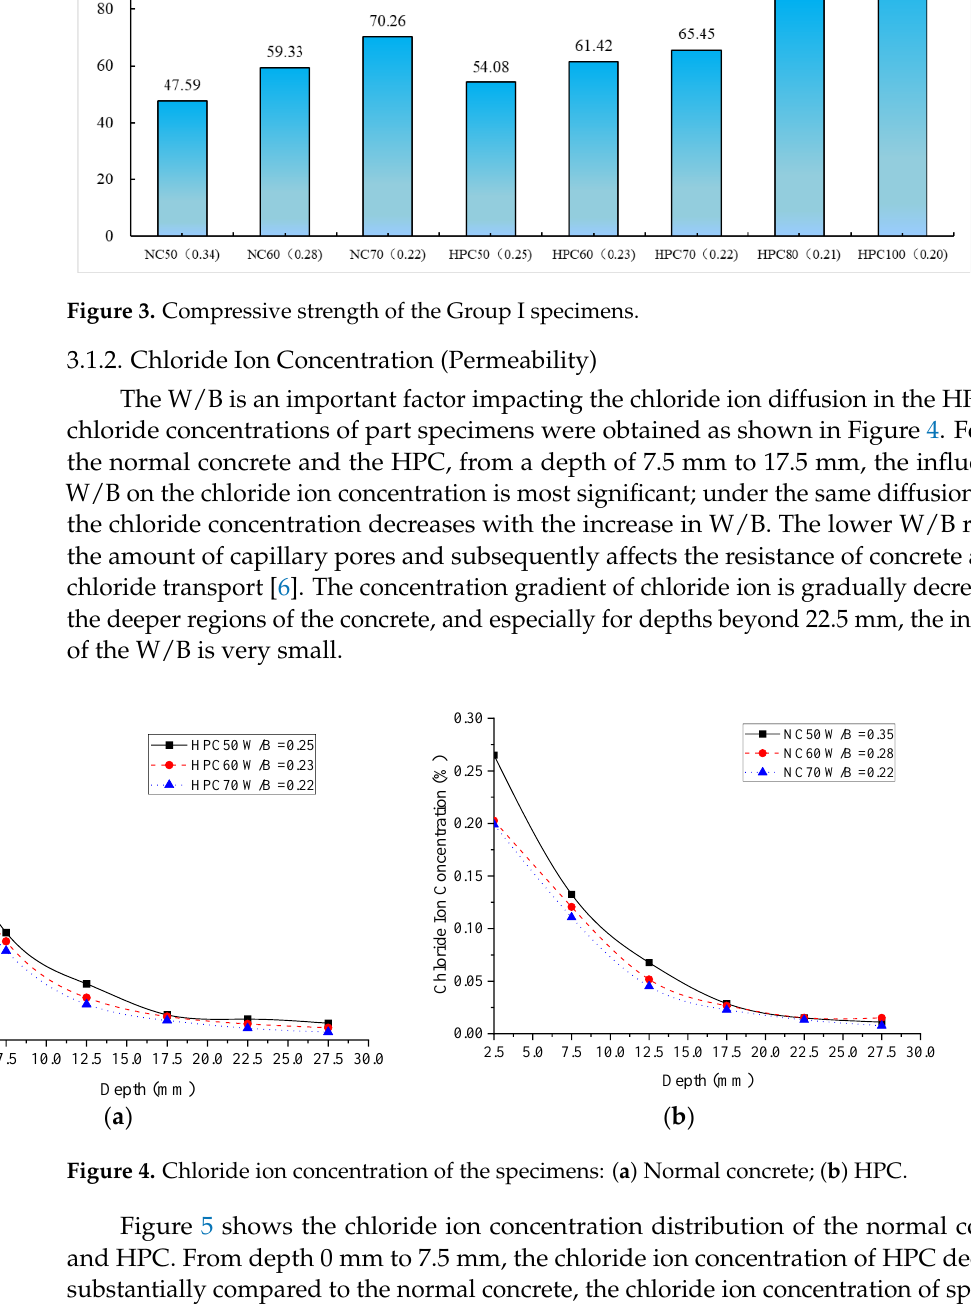
Figure 5. Chloride concentration distribution of Group Ⅰ specimens. 3.2. Influence of the Mixing Method of Mineral Admixtures 3.2.1. Concrete Compressive Strength The concrete compressive strengths of Group Ⅱ specimens are presented in Figure 6. For binary combination specimens SF5, SF10 and SF15, the concrete compressive strength increases 11.93% when the content of the silica fume increases from 5% to 15%. However, the concrete compressive strength of specimen SF15 is 5.69% smaller than specimen SF10. The same situation appears for the compressive strength of specimens FA10, FA20 and FA30. The experimental results conclude that the contents of the SF or FA developing the strength is limited. Figure 7 shows the concrete compressive strength of specimens with different FA content obtained by Jerath and Hanson [39], which also concludes that the concrete compressive strength at the same age firstly increases, then decreases with the FA content increases. Interestingly, it can be found from the strength of specimens F10-S5 to F30-S5 and F10-S10 to F30-S10, the compressive strength of specimens F10-S5 to F30-S5 decreases from 8.9% to 11.5% with the increase in FA when the content of the silica fume keeps unchanged. The compressive strength of specimens F10-S10 to F30-S10 decreases from 5.6% to 22.2% with the increase in SF when the content of the FA keeps unchanged.